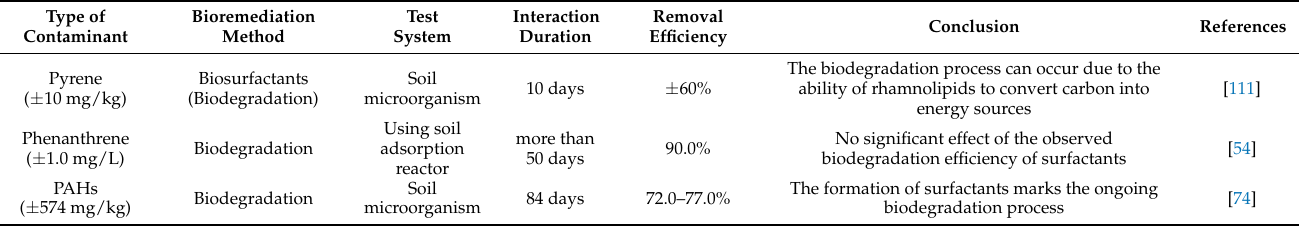
Table 1. Results of recent studies on the application, performance and efficiency of bacteria in the remediation of polycyclic aromatic hydrocarbons (PAHs) and heavy metal